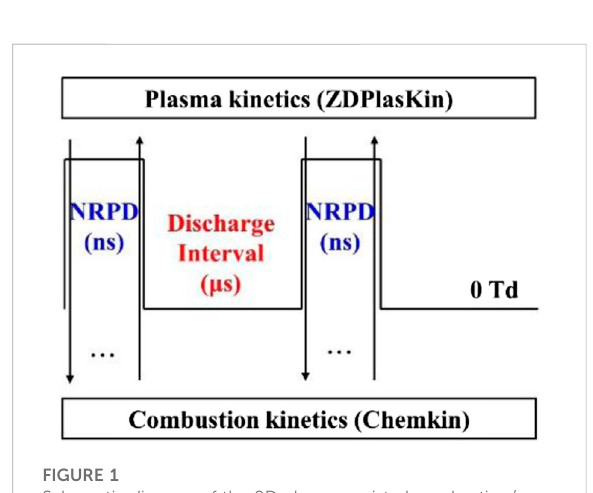
FIGURE 1 Schematic diagram of the 0D plasma-assisted combustion/ ignition